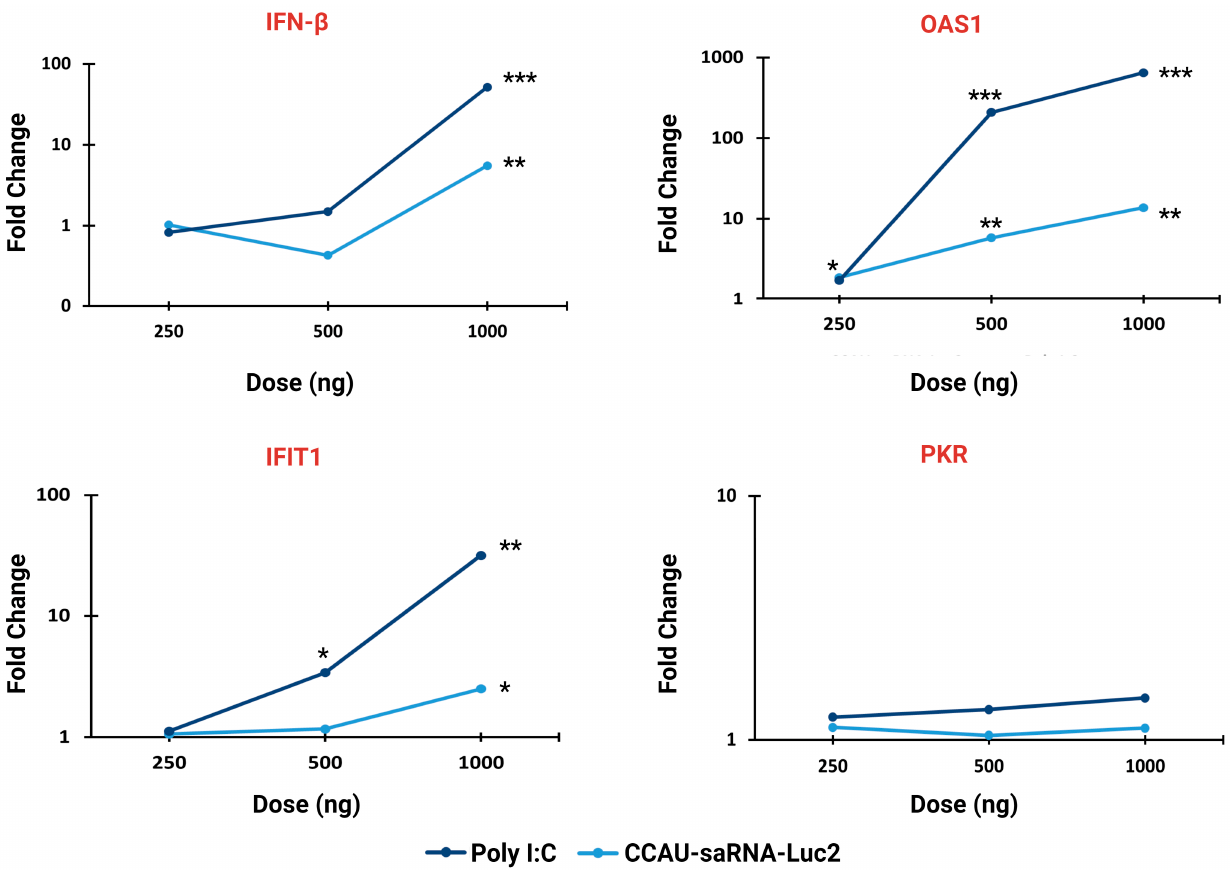
Figure 2. Innate immune response to saRNAs. Fold changes in mRNA transcripts encoding IFN- β and interferon-inducible genes ( OAS1 , IFIT1 , PKR ) in HEK 293T cells transfected with saRNA-Luc2, or Poly I:C. mRNA concentrations were determined using qRT-PCR and normalized to glyceraldehyde 3-phosphate dehydrogenase ( GAPDH ) expression. Relative fold change in expression between transfected and mock-transfected samples (n = 3) was determined using the delta delta Ct method. Poly I:C = positive control, INF- β = Interferon beta, OAS1 = 2 (cid:48) -5 (cid:48) -oligoadenylate synthetase 1, IFIT1 = interferon-induced proteins with tetratricopeptide repeats 1, PKR = Protein Kinase R. Significant differences between transfected and mock-transfected samples were calculated using a Student’s t -test. * p < 0.05, ** p < 0.01, *** p < 0.001, Created using Microsoft Excel and